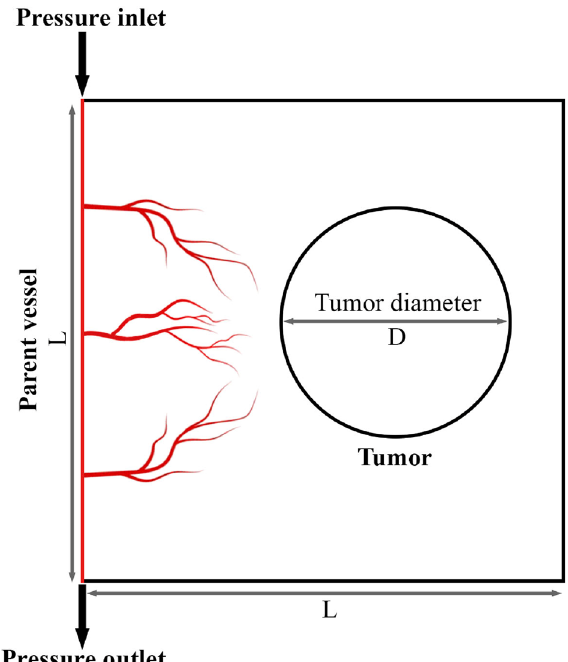
Figure 3. A schematic of the computational domain employed in the current study. The vascular network consists of a parent vessel located on the left side of the domain. It should be mentioned that Microsoft Office PowerPoint 365 was used to create this